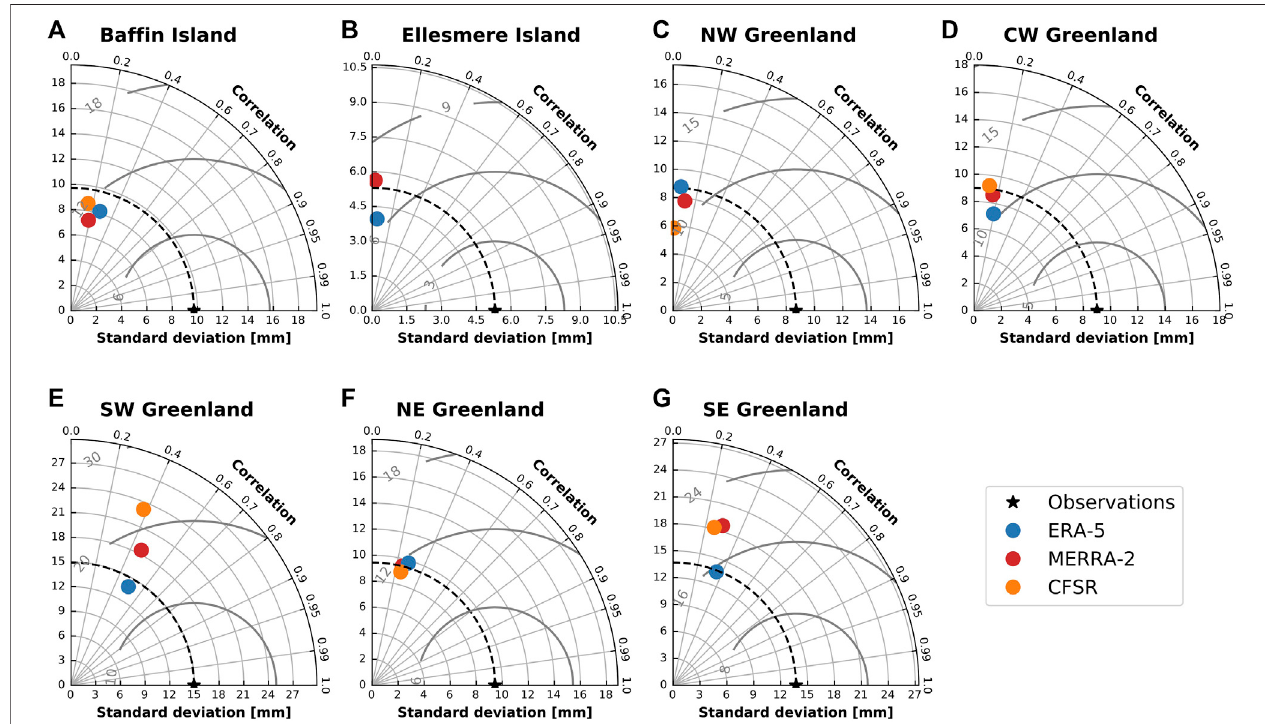
FIGURE 2 | Taylor diagrams comparing accumulations for extreme events between products in each subregion (A – G) . CFSR is not visible in (B) due to the correlation falling below 0 and MERRA-2 is overlain by ERA-5 in (F) .